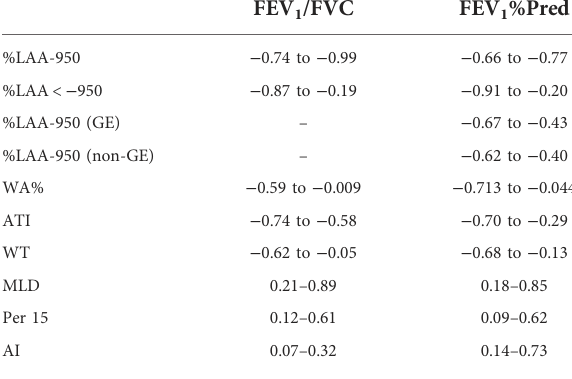
TABLE 1 Correlation coef fi cients between CT measurements and air fl ow obstruction parameters of pulmonary function test in the systematic